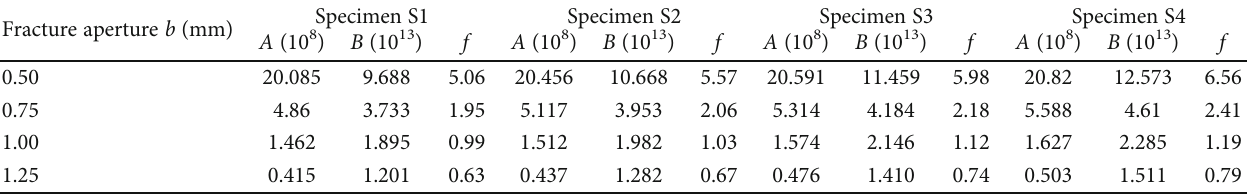
Table 3: Fitting coe ffi cients A and B in the Forchheimer equation and corresponding critical Reynolds numbers. Fracture aperture b